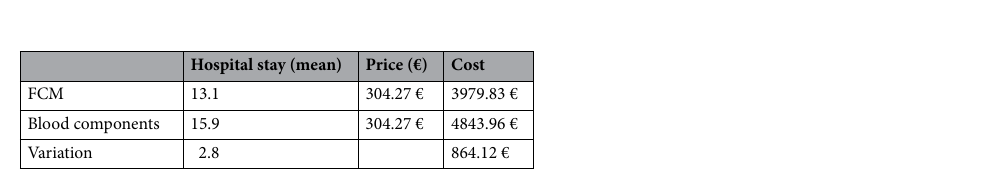
Table 8. Costs of hospital stay (€/patient).